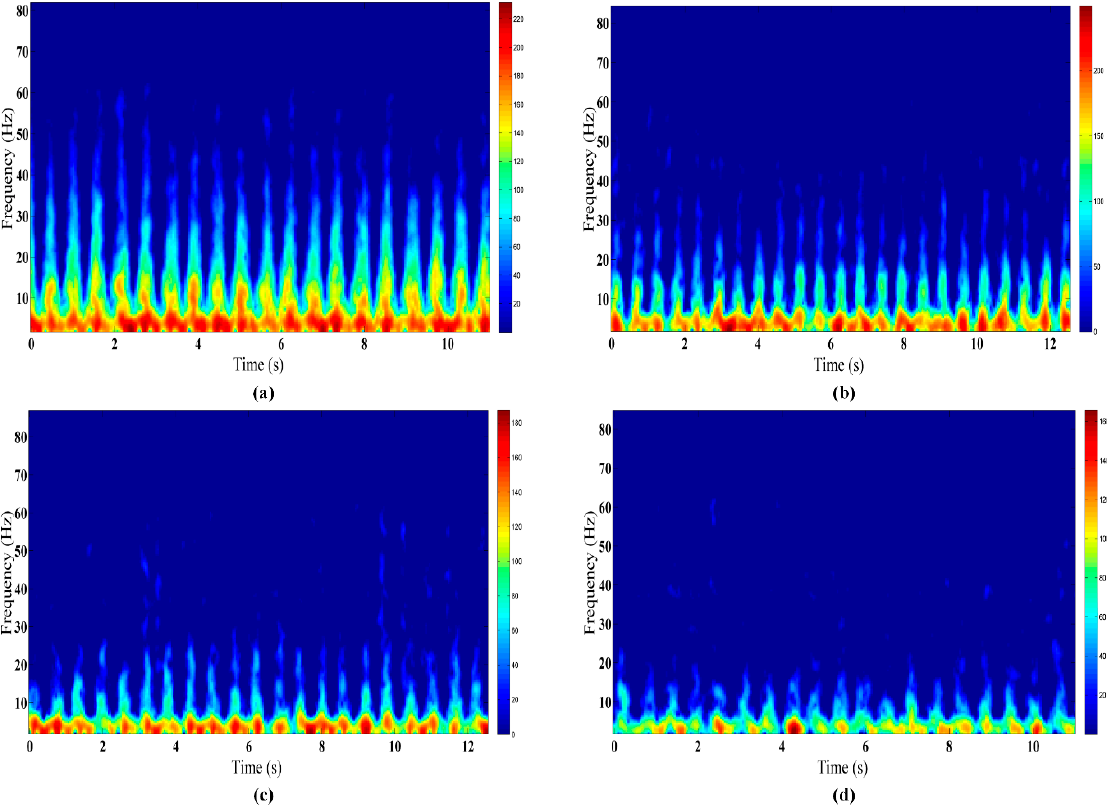
Figure 7. Spectrograms of the piaffe activity at different positions: ( a ) 3 m, ( b ) 4 m, ( c ) 5 m, and ( d ) 6 m.